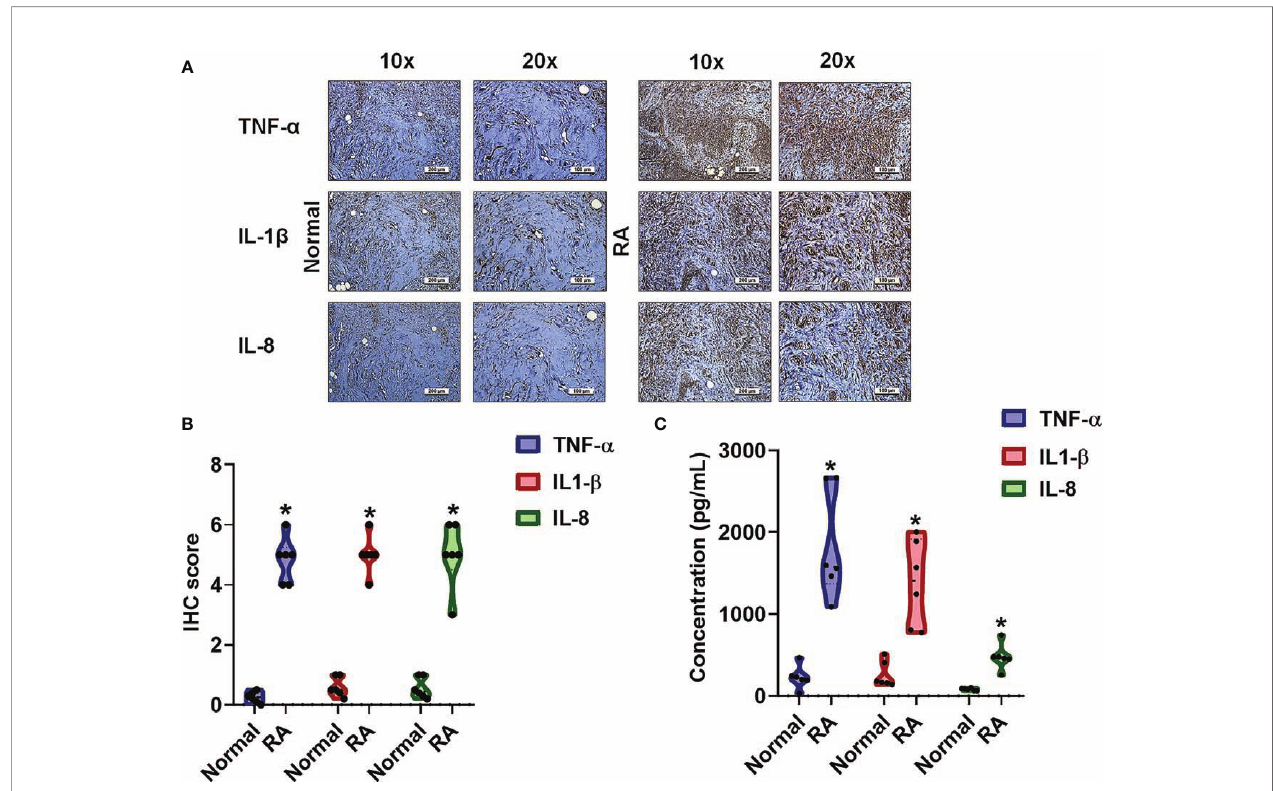
FIGURE 1 | The identi fi cation of cytokines that interfere with RA severity. (A, B) RA and normal synovial tissue specimens were analyzed by IHC. (C) Cytokine plasma levels were upregulated in RA patients. ELISA assessments of blood samples (N=6) from RA patients and healthy volunteers determined levels of TNF- a , IL- 1 b and IL-8. Results are expressed as the mean ± SD. * P < 0.05 compared with